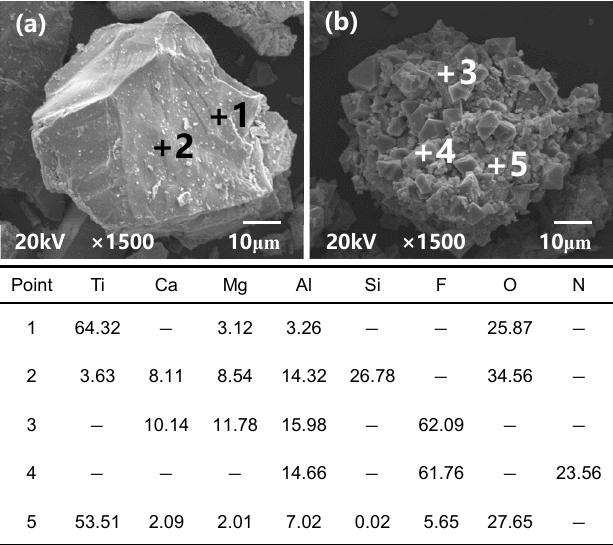
Figure 6. SEM images and EDS analysis of TEFS and fluoride leaching residue (wt%). ( a ) TEFS; ( b ) fluoride leaching residue at 60 °C with F − concentration of 10 mol/L, leaching time of 30 min, L / S ratio of 20:1, and rotating speed of 200 r/min.